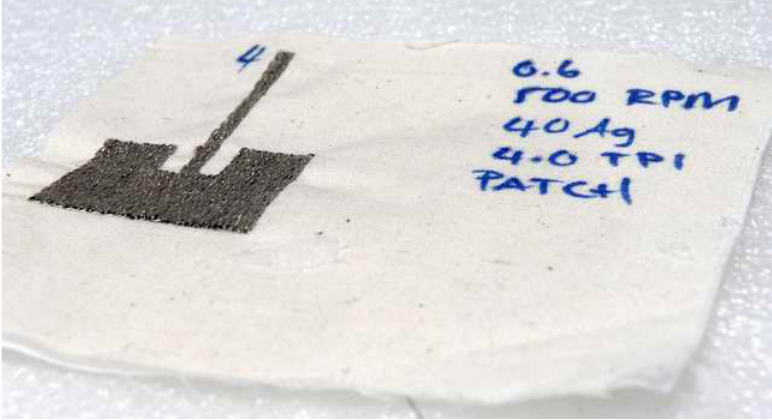
Figure 6. Embroidered patch antenna.